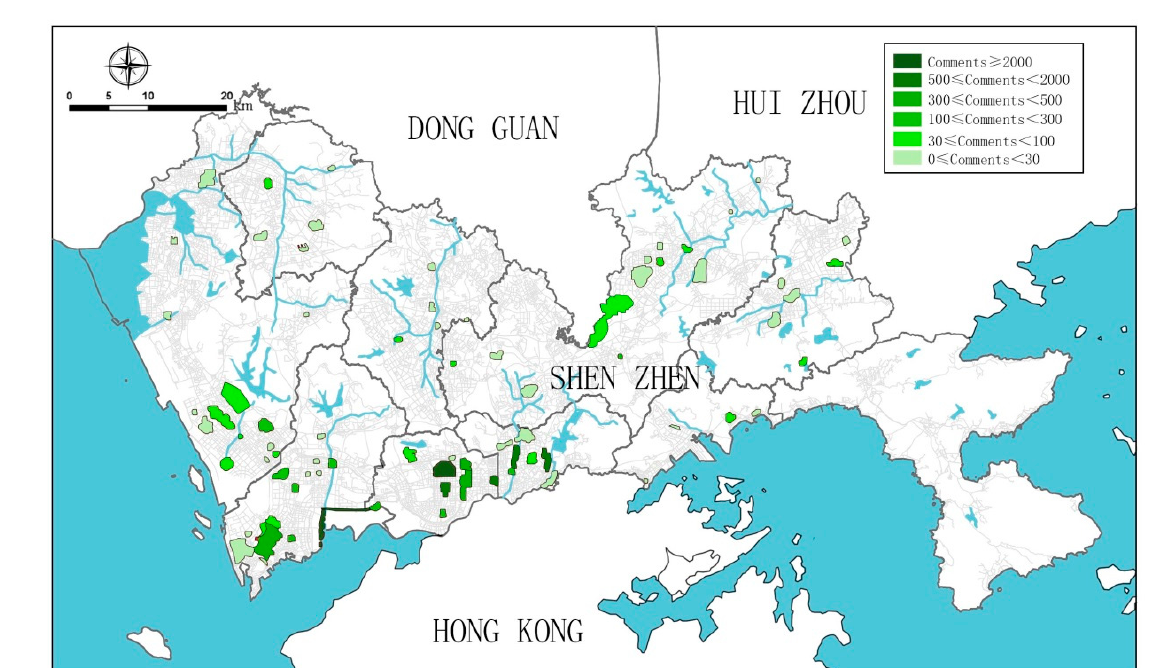
Figure 3. Distribution of comments to Shenzhen’s comprehensive parks measured by Dianping data (Drawn by the authors).